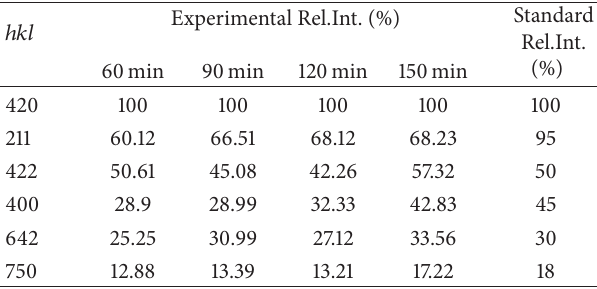
Standard Rel.Int.